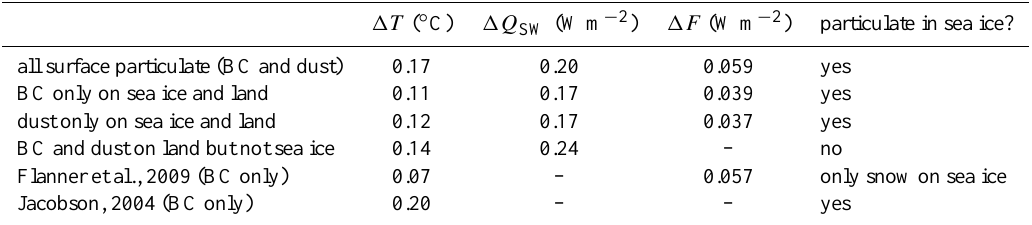
Table 1. Global annual mean two meter temperature change, 1T , change in net TOA shortwave radiation, 1Q SW , and radiative forcing, 1F . See Sect. 4.1.1 for a detailed description of 1F